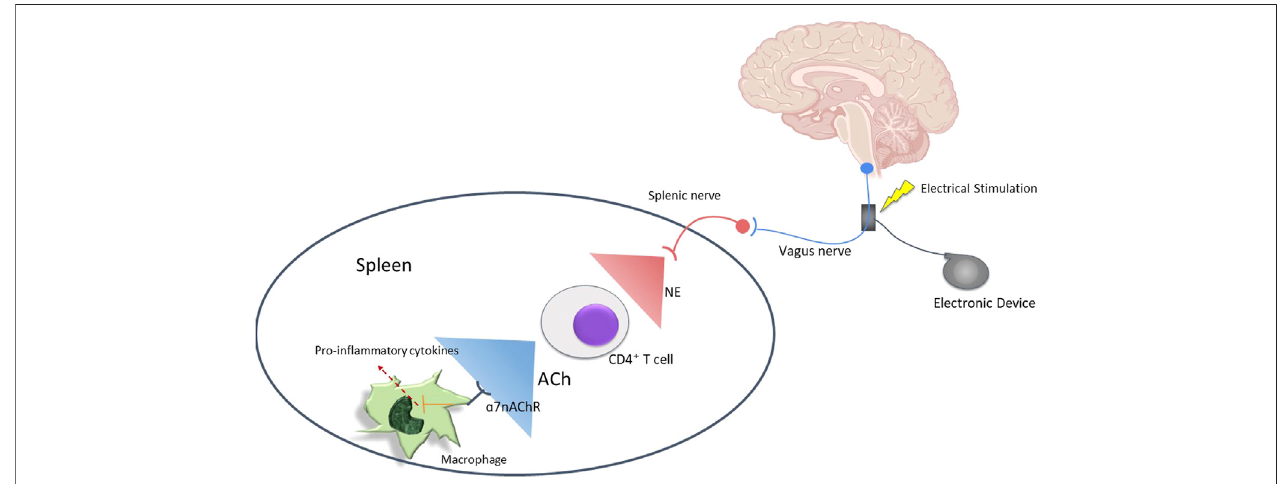
FIGURE 5 | Mechanism of immunomodulation by the Vagus nerve. Vagus nerve can be stimulated to induce T cells to release acetylcholine which can increase macrophage production and